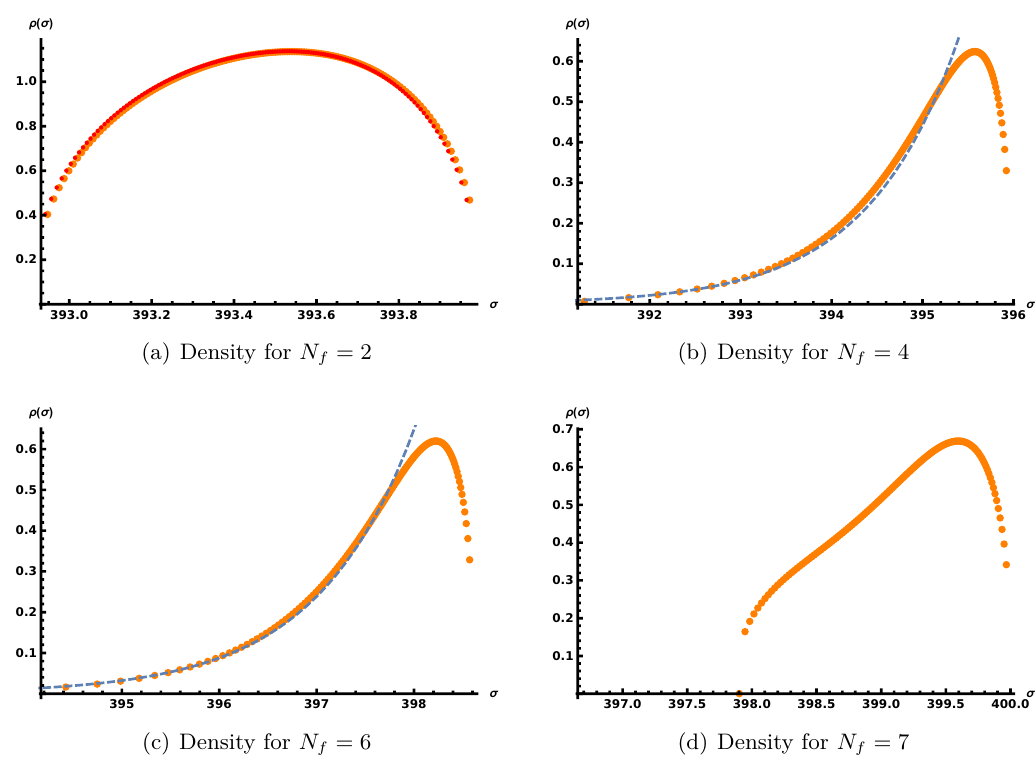
Figure 9 . Eigenvalue density ρ ( δσ ) for λ